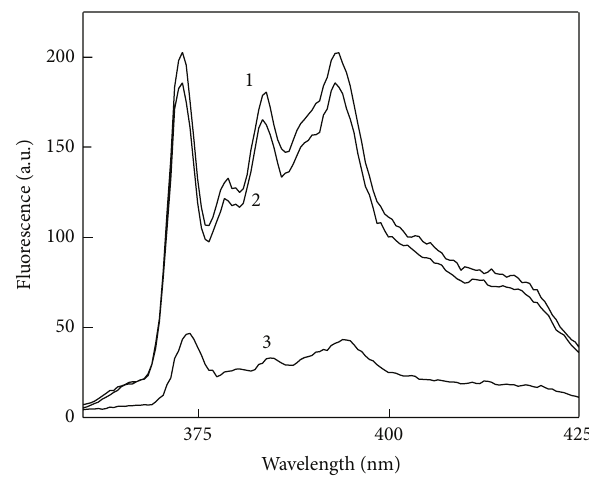
Figure 4: Fluorescence spectra of pyrene ( 𝜆 ethanolic solution: (1) prior to sorption, (2) after sorption on the CDA fiber, and (3) on the CDA